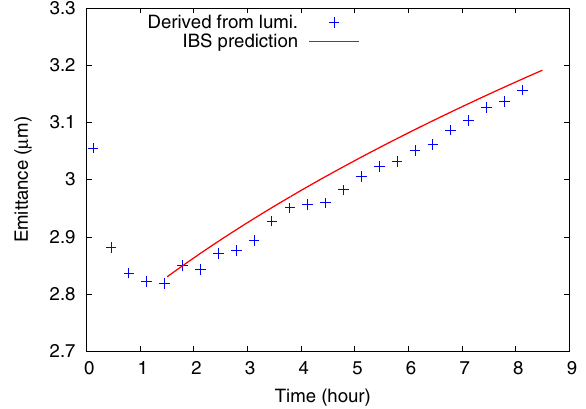
FIG. 14. Numeric modeling of emittance growth with collision at store. Initial beam parameters similar to Fill 16697 are used.